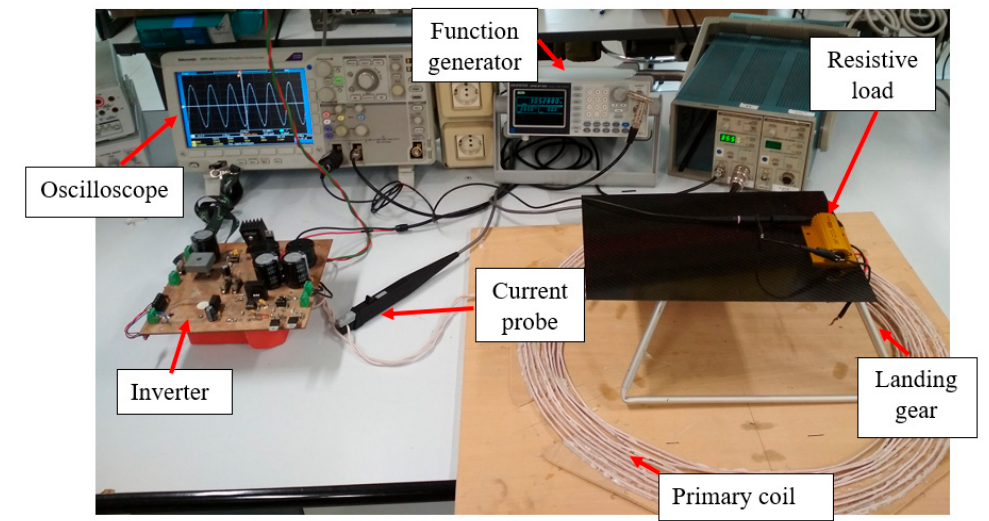
Figure 14. Measurement setup.